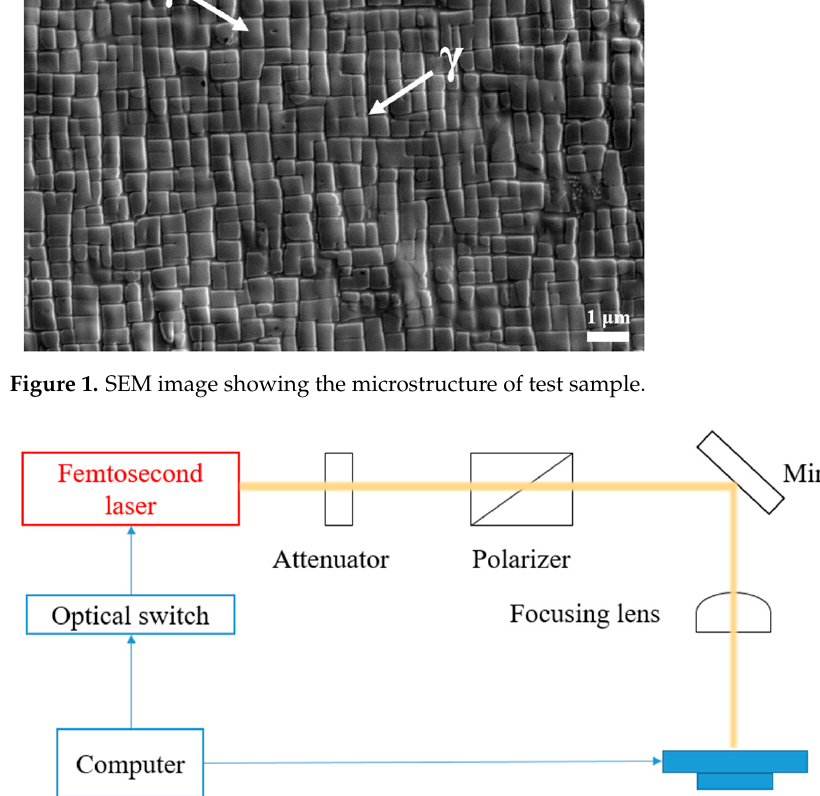
Figure 2. Optical path diagram of femtosecond laser processing.